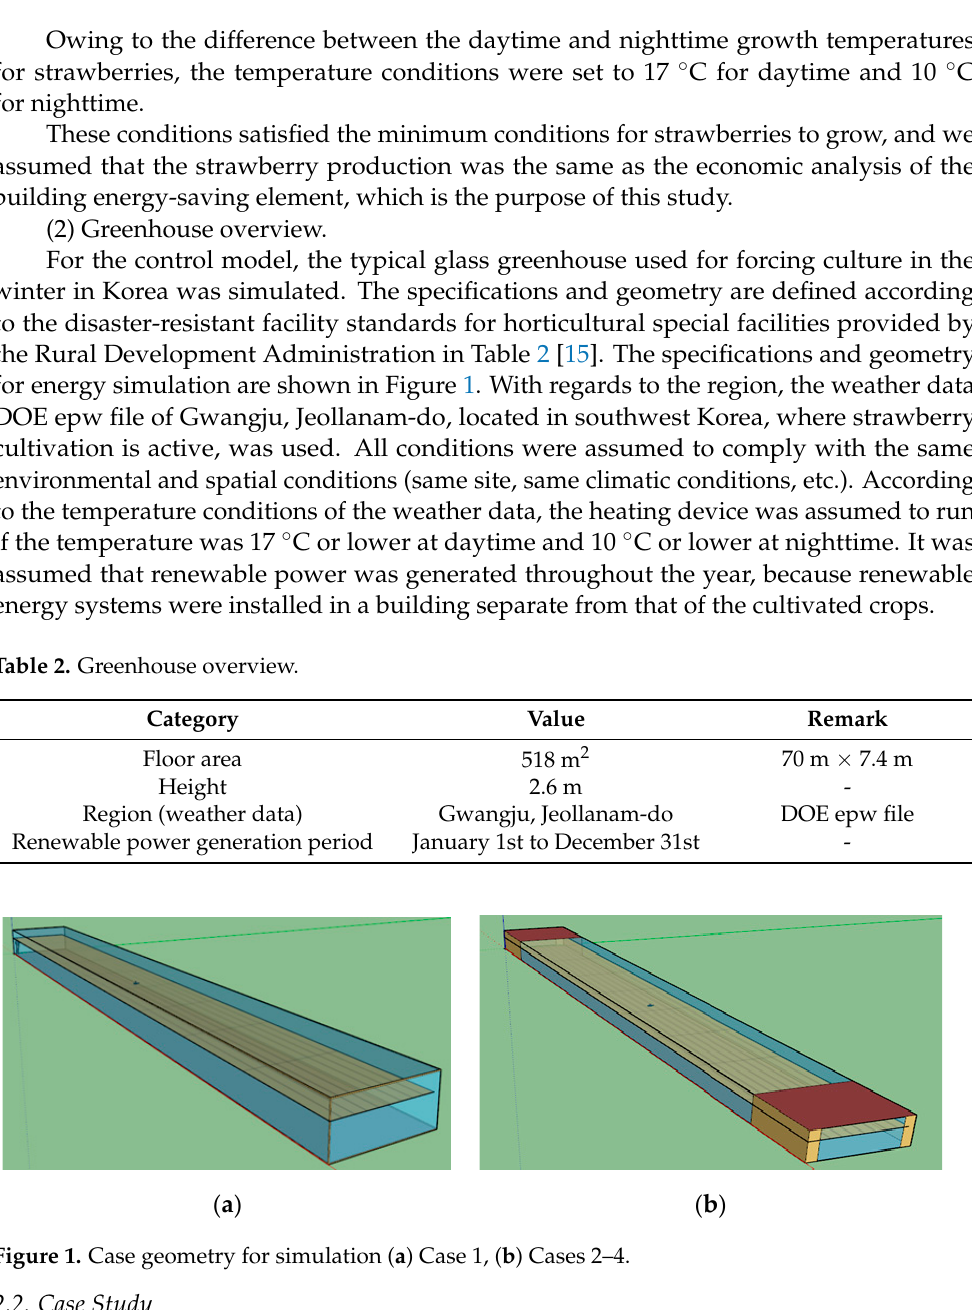
Table 1. Strawberry cultivation conditions.